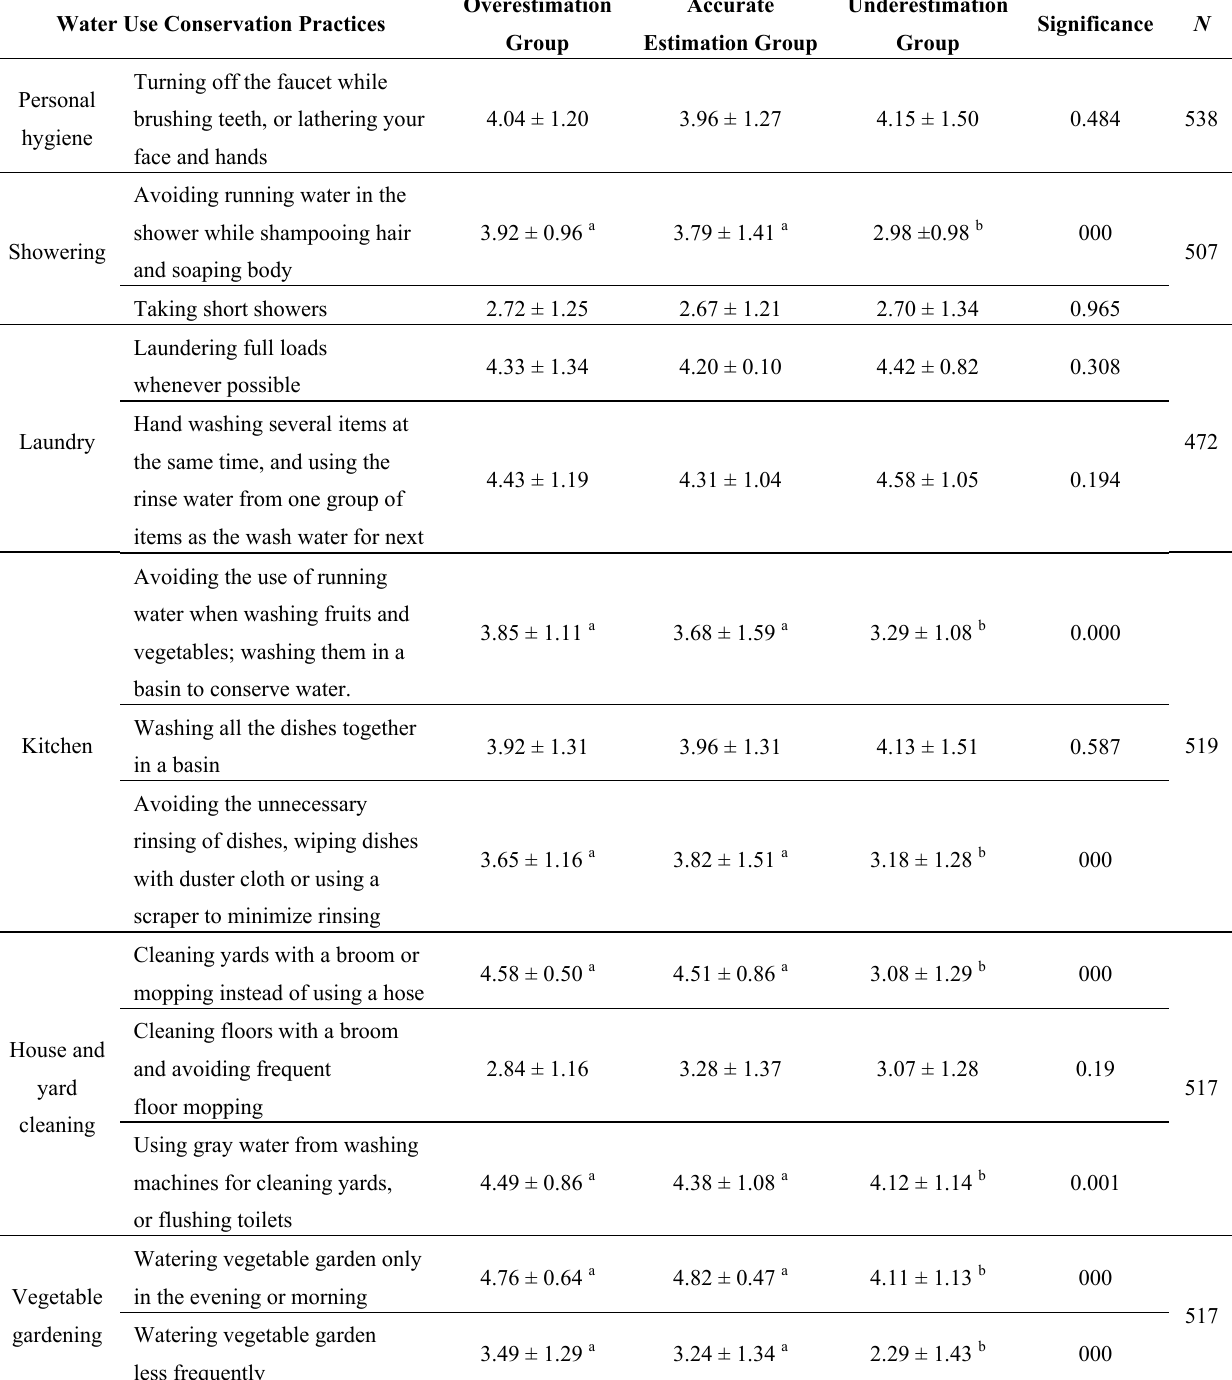
Table 6. Water conservation practices under different perception groups for each water use pattern (Mean ±